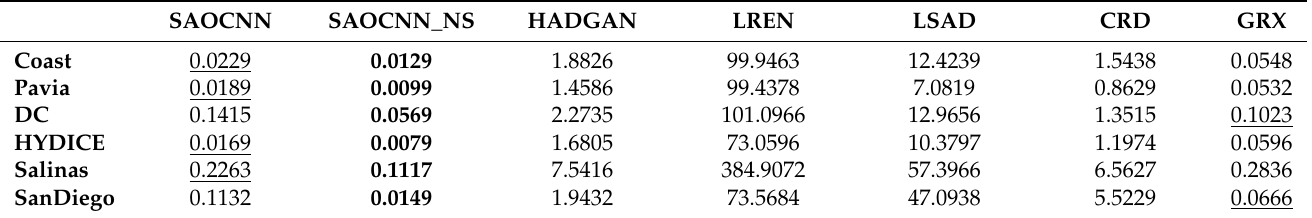
Table 4. Operation time in seconds of SAOCNN, SAOCNN_NS, HADGAN, LREN, LSAD, CRD, and GRX. (The minimum is in bold and the second is